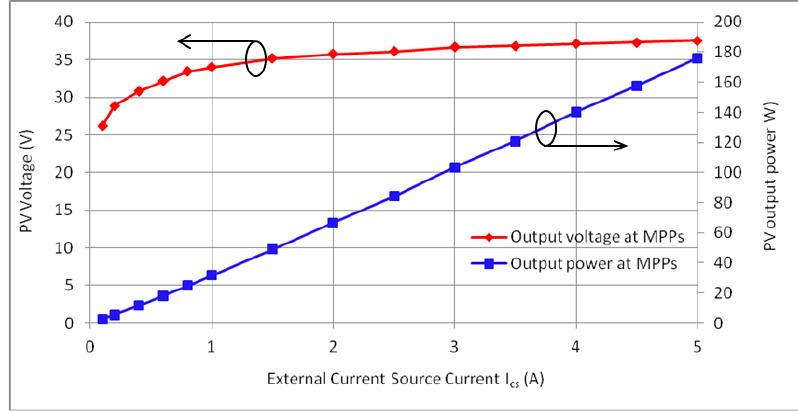
Figure 18. Measured I cs − P MMP and I cs − V MMP curves of the constructed PV source using a single un-illuminated solar panel.